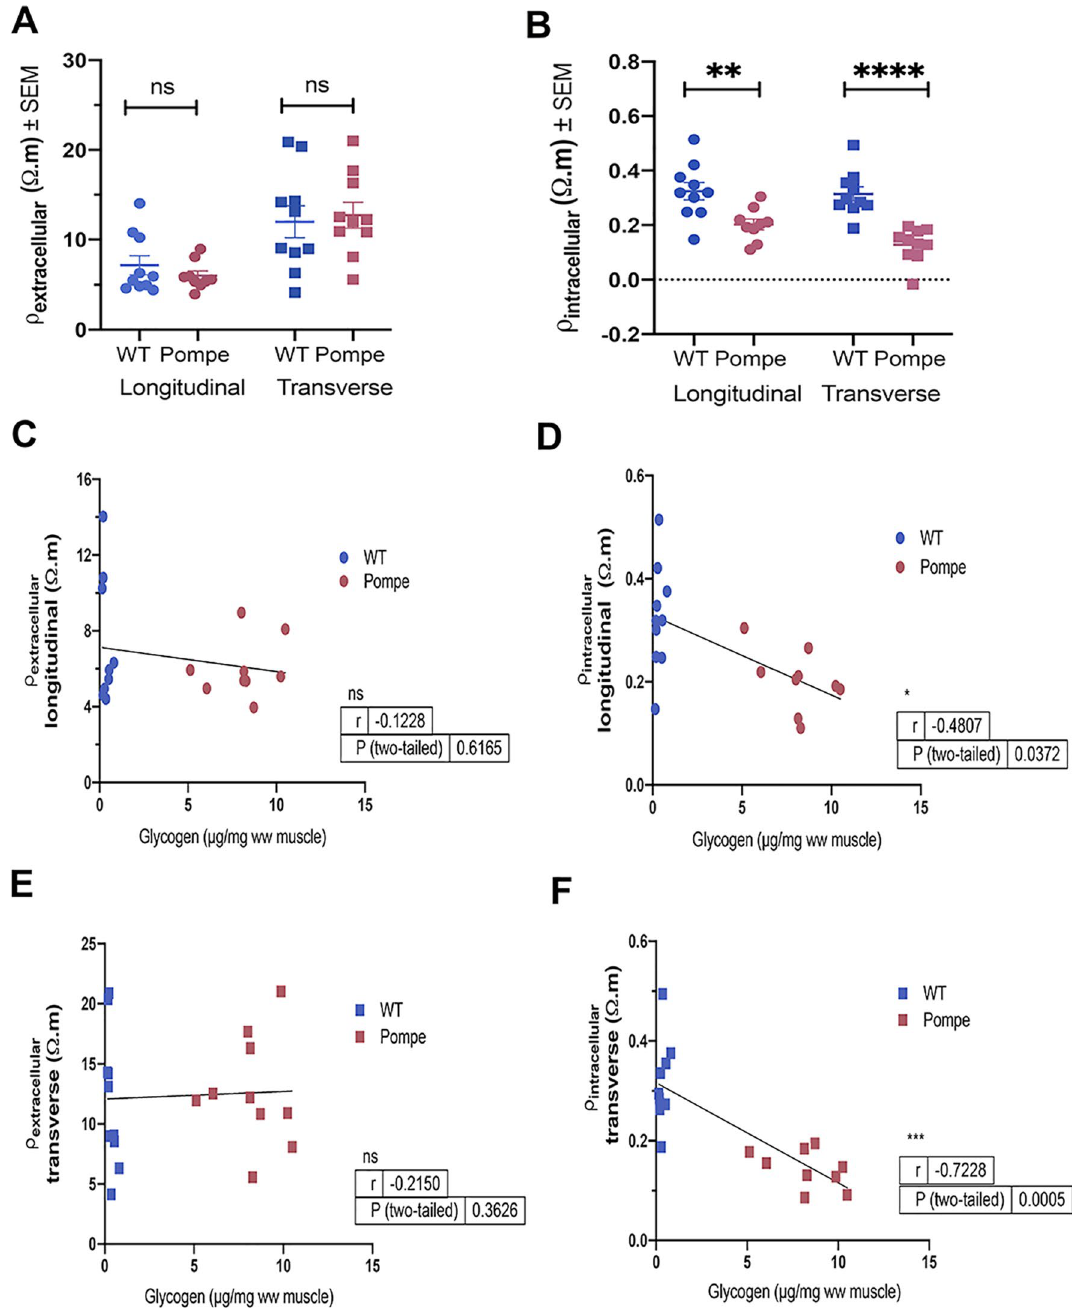
Figure 6. Extracellular and intracellular resistivity of WT and Pompe gastrocnemius muscle. Extracellular resistivity, ρ extracellular ( A ) and intracellular resistivity, ρ intracellular ( B ) values for WT and Pompe GA muscle at 30 weeks (shown with mean ± SEM). Scatter plots showing correlations between glycogen content (GC) and extracellular resistivity, ρ extracellular ( C , E ) and intracellular resistivity, ρ intracellular ( D , F ) in the longitudinal and transverse directions. (Unpaired t-test). * p < 0.05; ** p < 0.01; *** p < 0.001; **** p < 0.0001; ns not